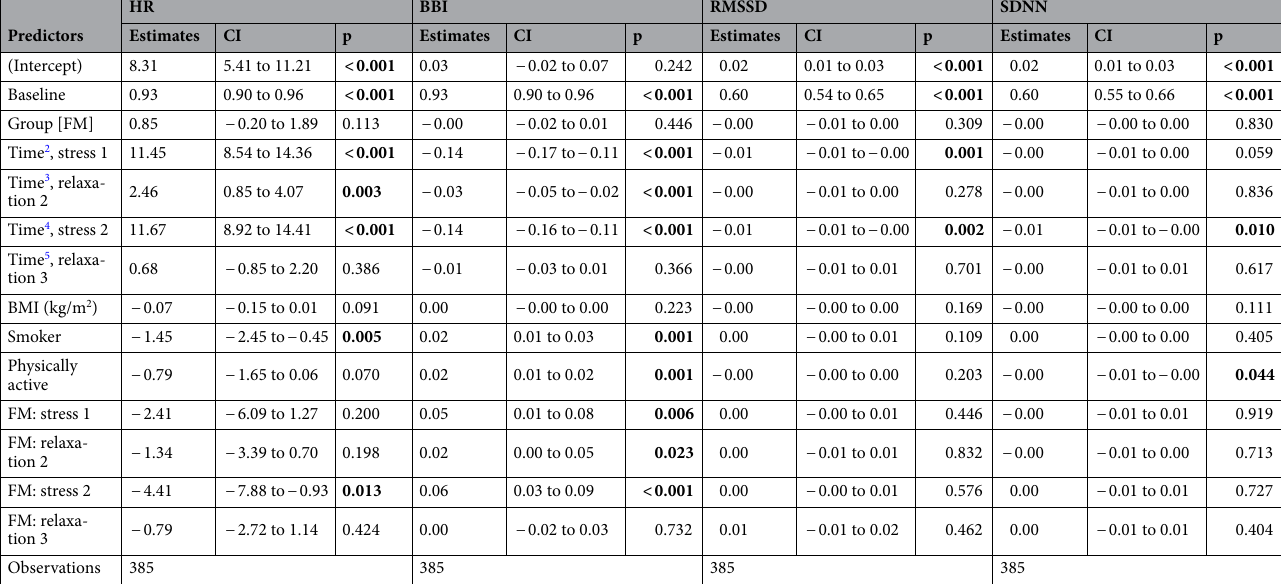
Table 3. Generalized linear models for heart rate (HR), mean interval between heart beats (RR mean ), root mean squared interval differences of successive beats (RMSSD), and the standard deviation of intervals between normal heart beats (SDNN), comparing fibromyalgia patients (FM) and healthy controls, adjusted for lifestyle factors. Significant values are in